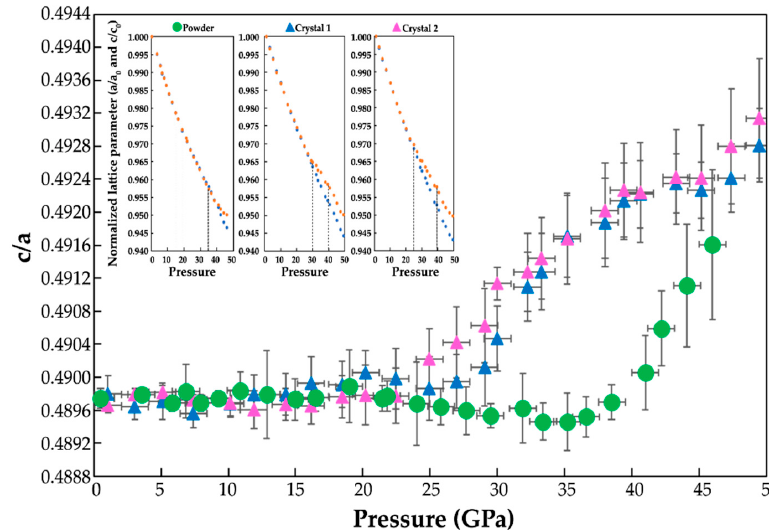
Figure 2. The c / a axial ratio of Ni 3 P at di ff erent pressures at room temperature. The graphs at the Figure 2. The c/a axial ratio of Ni P at different pressures at room temperature. The graphs at the top- 3 top-left corner are the normalized lattice parameters (a / a 0 and c / c 0 ) of Ni 3 P from this study. left corner are the normalized lattice parameters (a/a 0 and c/c 0 ) of Ni P from this study. 3